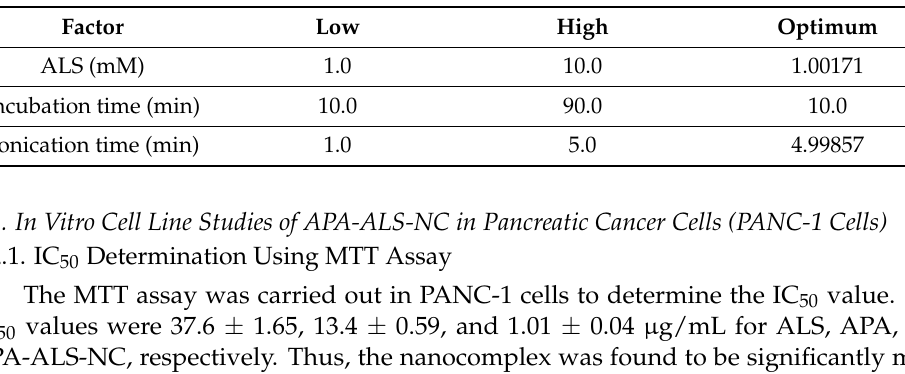
Figure 2. Particle size analysis using zetasizer ( A ) and TEM ( B ).